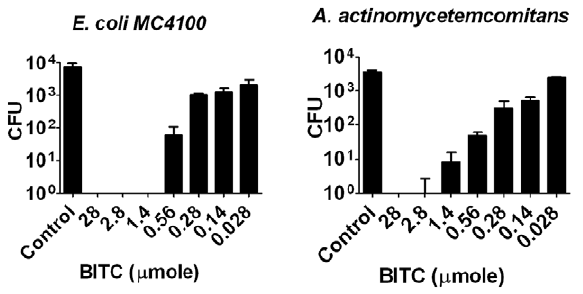
Figure 3. Antibacterial activity of commercial synthetic BITC against two Gram-negative bacteria. The individual bars show the statisticalmeanandstandarddeviationof thenumber of survivingbacteria from three experiments. The amount of BITC applied corresponds to the BITC content in the different oil dilutions of figure 1; 28 m mole (1% oil), 2.8 m mole (0.1% oil), 1.4 m mole (0.05% oil), 0.56 m mole (0.02% oil), 0.28 m mole (0.01% oil), 0.14 m mole (0.005% oil) and 0.028 m mole (0.001% oil) pure BITC, respectively. Control is with DMSO only.